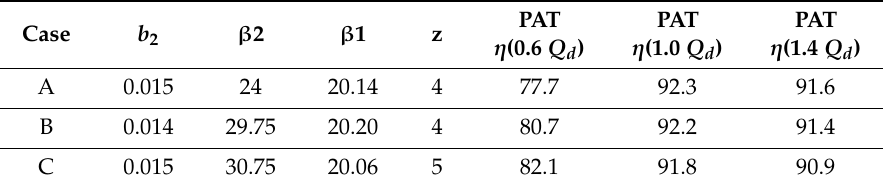
Figure 18. Pareto-frontiers from GRNN. Table 13. Variables for optimum cases.